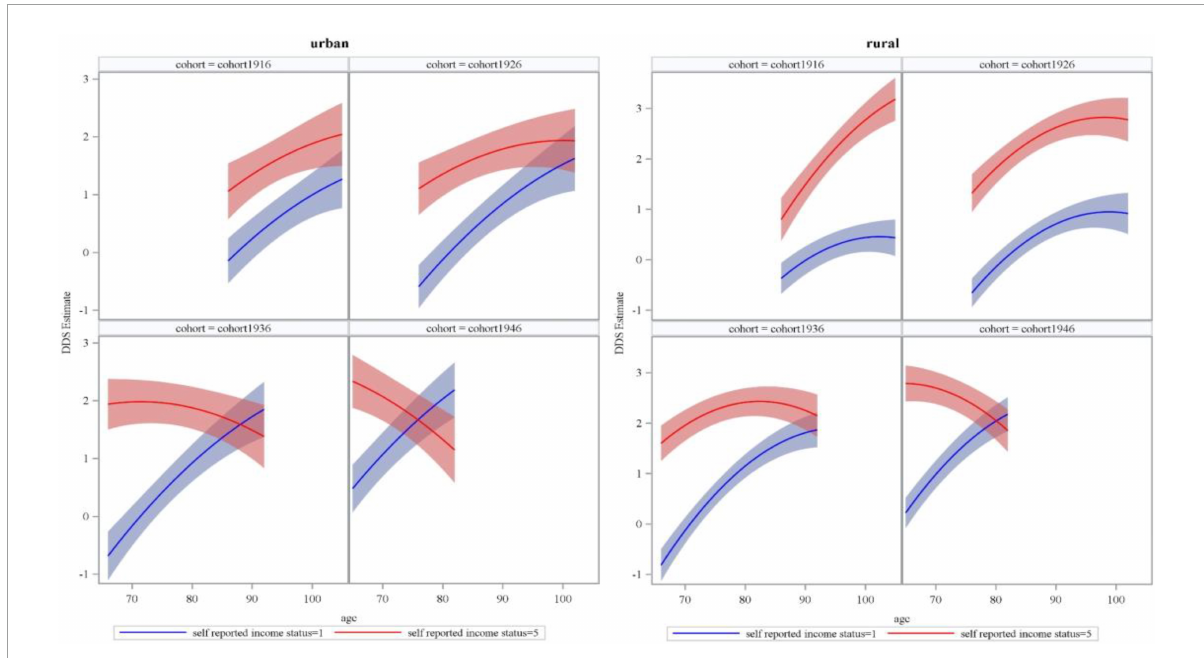
FIGURE4 Estimated dietary diversity score (DDS) of perceived or self-reported income status with age and across successive cohorts in urban and rural older